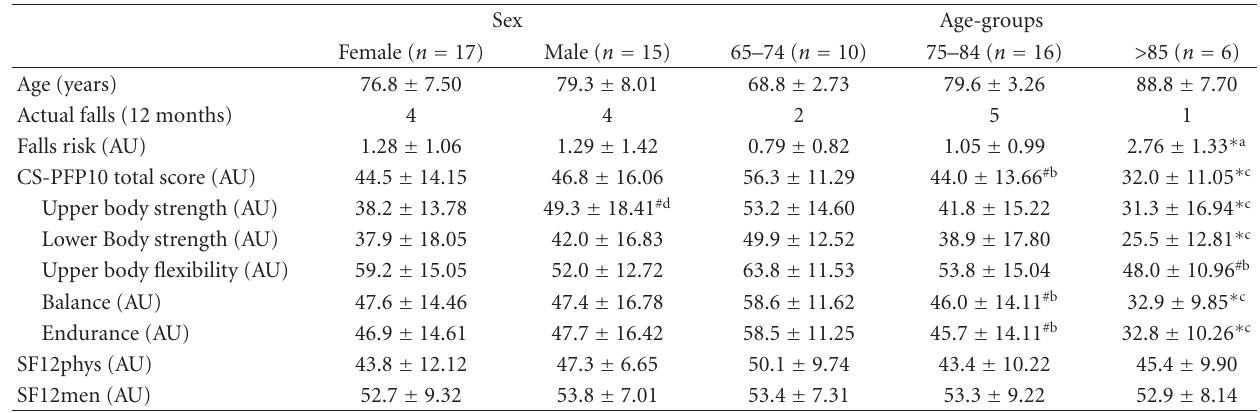
Table 1: Sex and age-group di ff erences in falls risk, physical functional performance, and health for sample participants (aged 65–92 years).